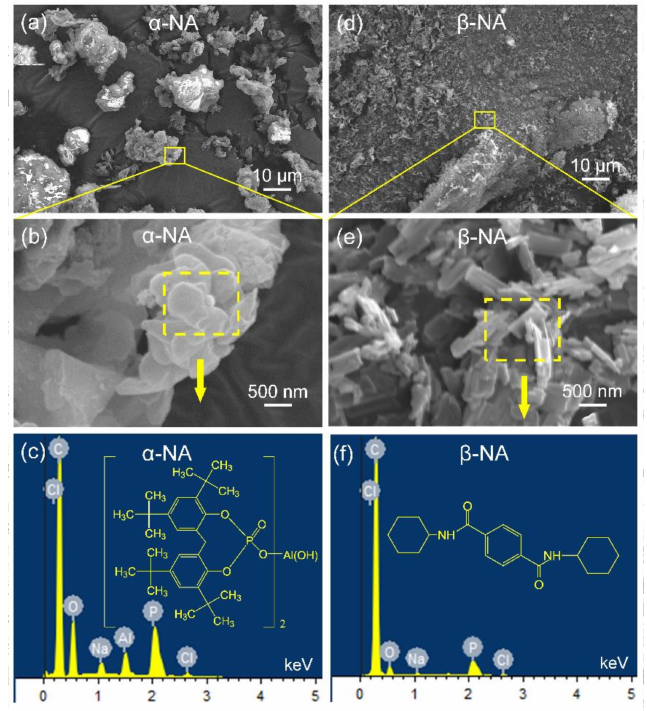
Figure 3. Geometric shapes and element compositions of NAs are observed by FESEM and EDX: ( a – c ) α -NA, ( d – f ) β